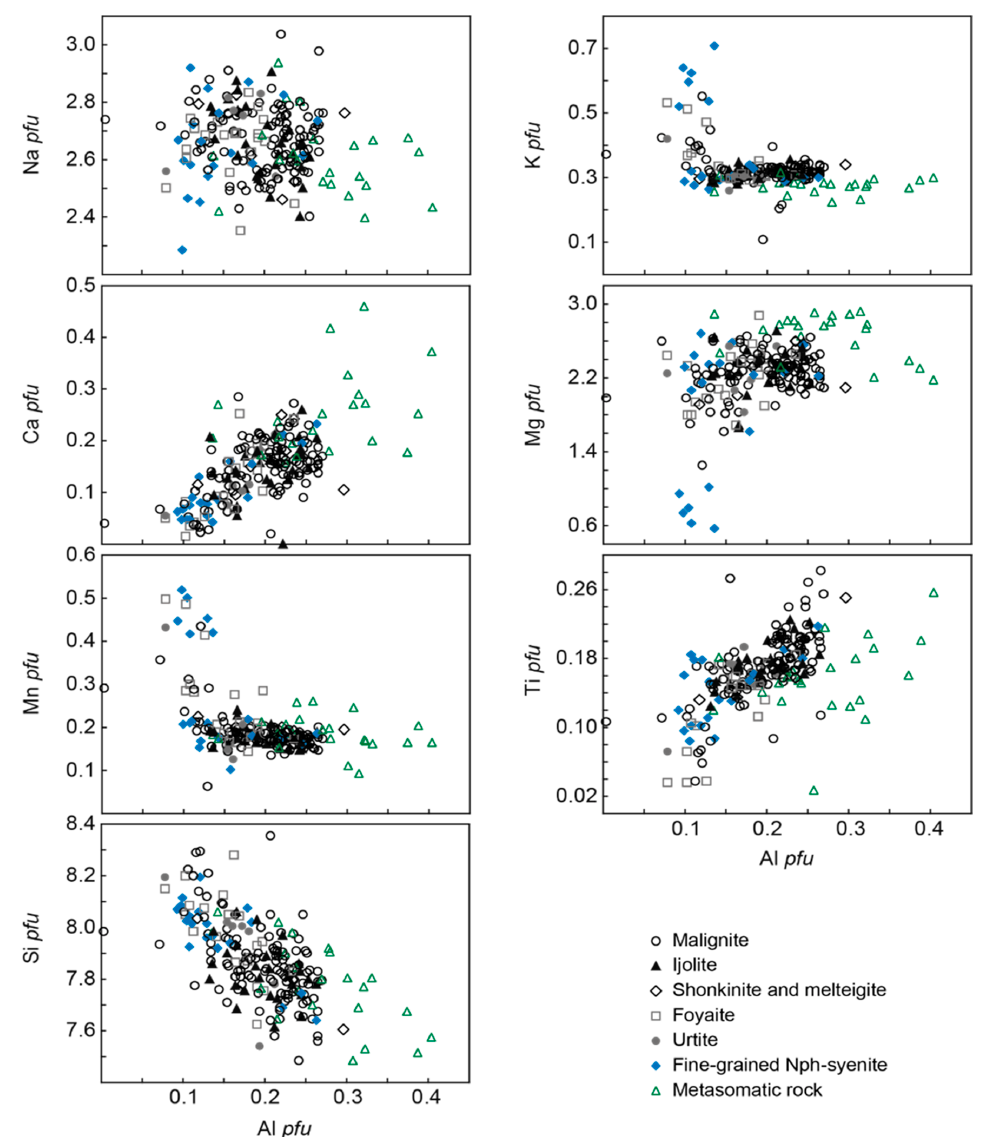
Figure 14. Binary diagrams showing major and minor element concentrations in amphiboles as a function of Al content.